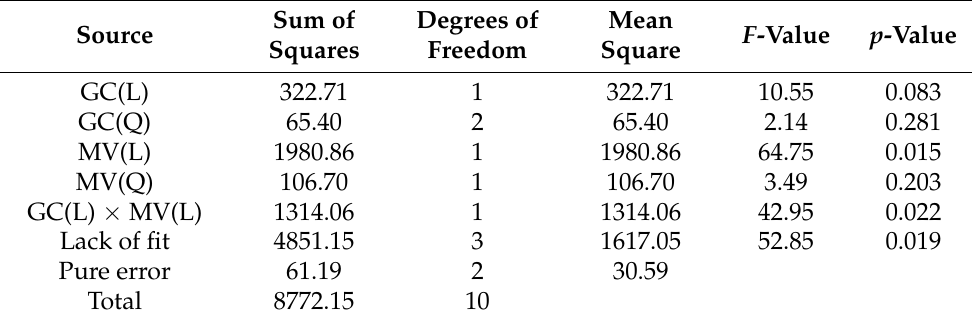
Table 4. Results of the analysis of variance applied to the results of the central composite rotational design used for protease production by Aspergillus tamarii URM4634 in sequential fermentations using wheat bran as a